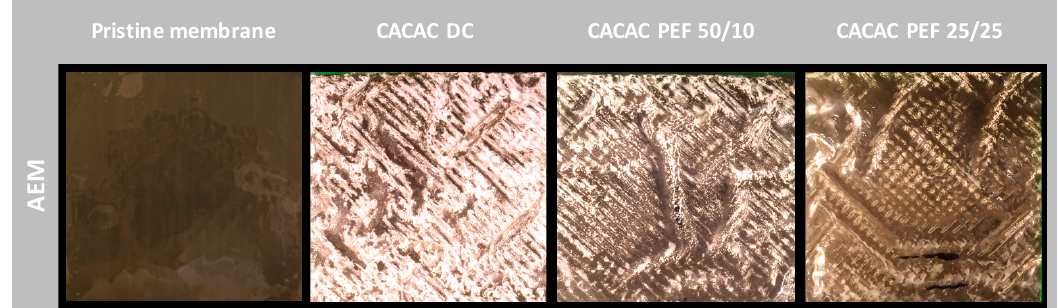
Figure 5. Entire anion-exchange membranes’ (AEMs’) anode sides (10 cm 2 ) photographs before and after ED for all three current conditions. AEM comprised of A1 and A2 with no visible differences.